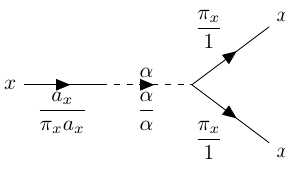
α 2 x Figure 4. Diagram for interaction x + y β −→